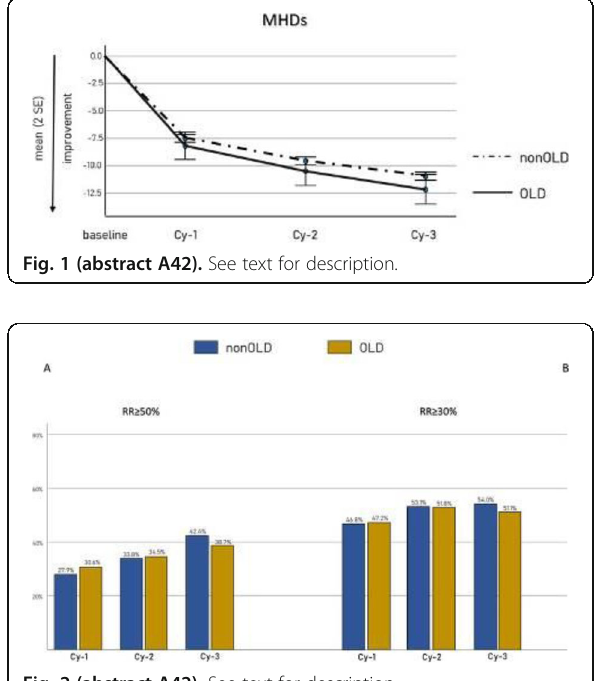
Fig. 2 (abstract A42). See text for